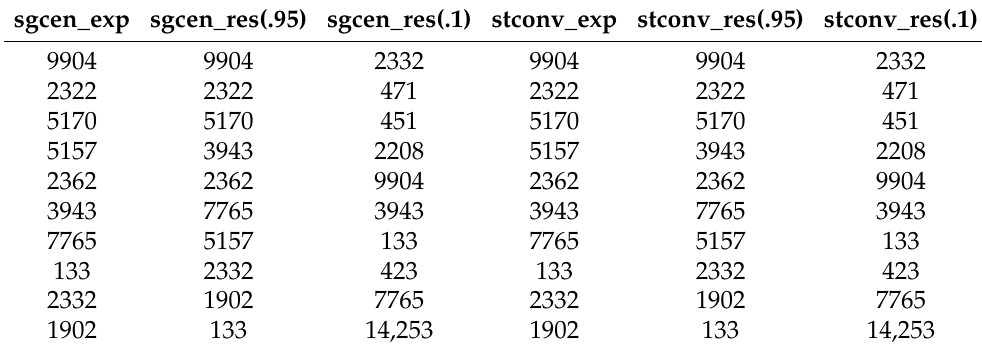
Table 5. Ranking of the 10 most important nodes for the facebook network identified by the f - subgraph centrality and f -starting